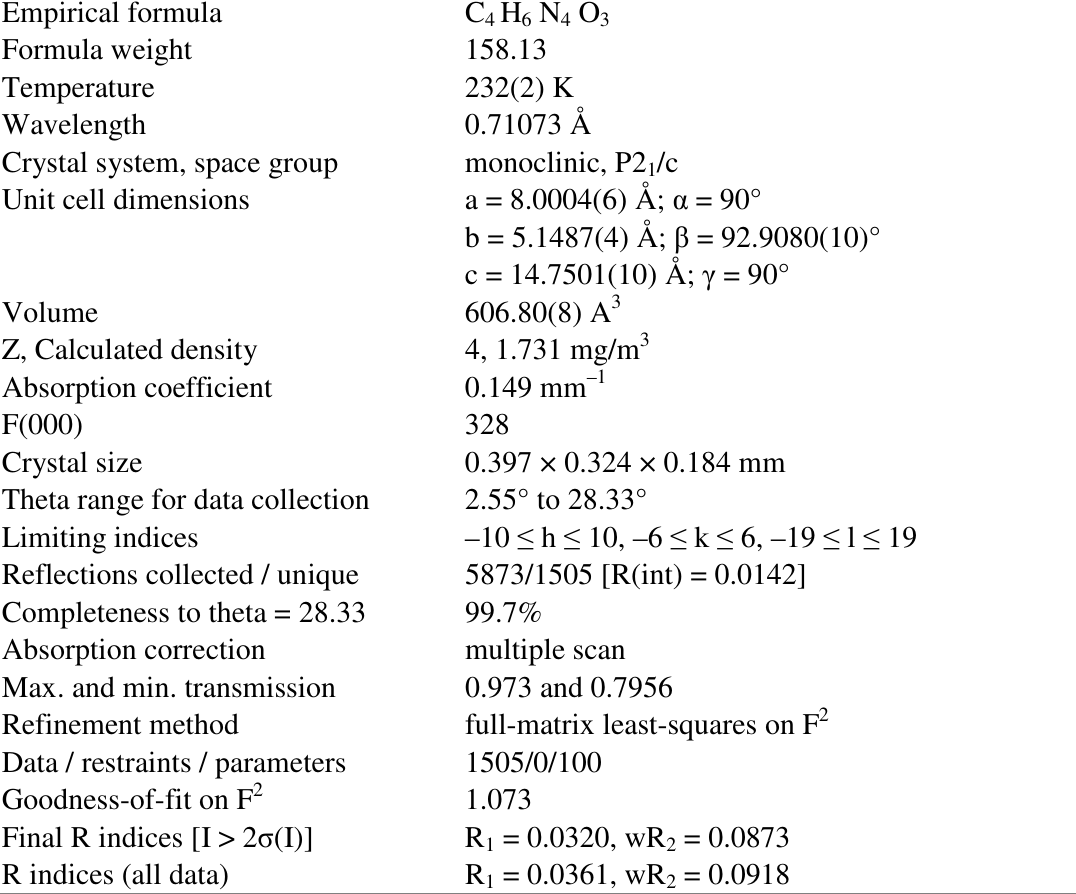
Table 2. Crystal data and structure refinement for allantoin from U. esculenta